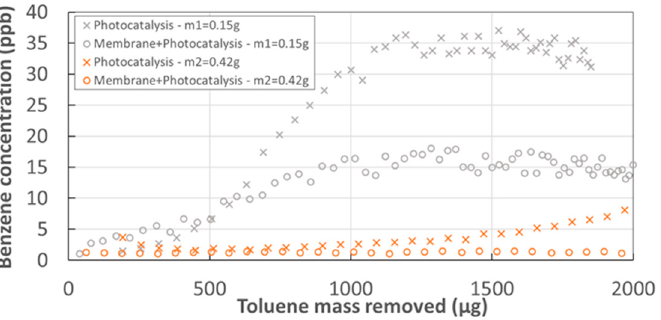
Figure 7. Evolution of benzene concentration in the retentate flow vs. toluene mass removed for catalysts m 1 and m 2 — PDMS membrane—Sweep gas = 0 % − I abs = 6.9 W m − 2 − ψ =